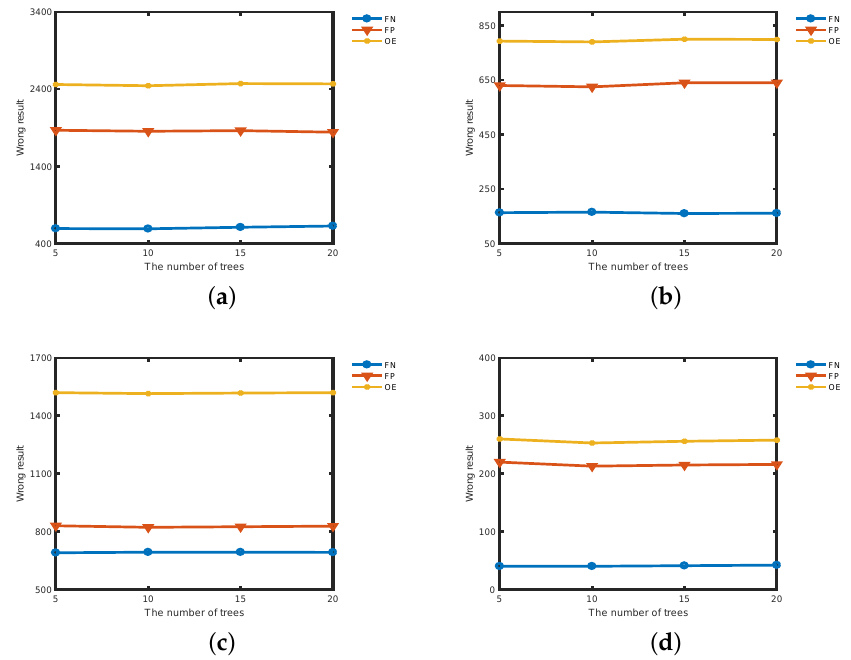
Figure 23. The wrong results on the different numbers of trees in the cascade of four types of data. ( a ) Farmland D data set. ( b ) Farmland C data set. ( c ) Inland water data set. ( d ) Coastline data